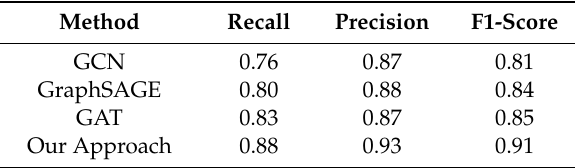
Table 3. Comparison of di ff erent algorithms on the